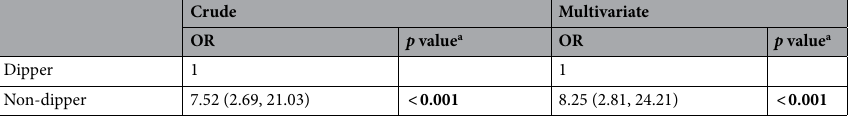
Multivariate analysis. The results of a multivariate analysis of factors associated with macular ischemia are depicted in Tables 4 and 5. The multivariable linear regression analysis was adjusted for all parameters (age, sex, body mass index, current smoking status, and alcohol drinking status). The factor that remained significant in the multivariate analysis was the night-to-day systolic BP ratio (β = − 0.313, p = 0.004). In logistic regression analysis of macular ischemia and dipping patterns, the non-dipper group was 8.25 times riskier in multivariate analysis than the dipper group ( p < 0.001, Table 5).